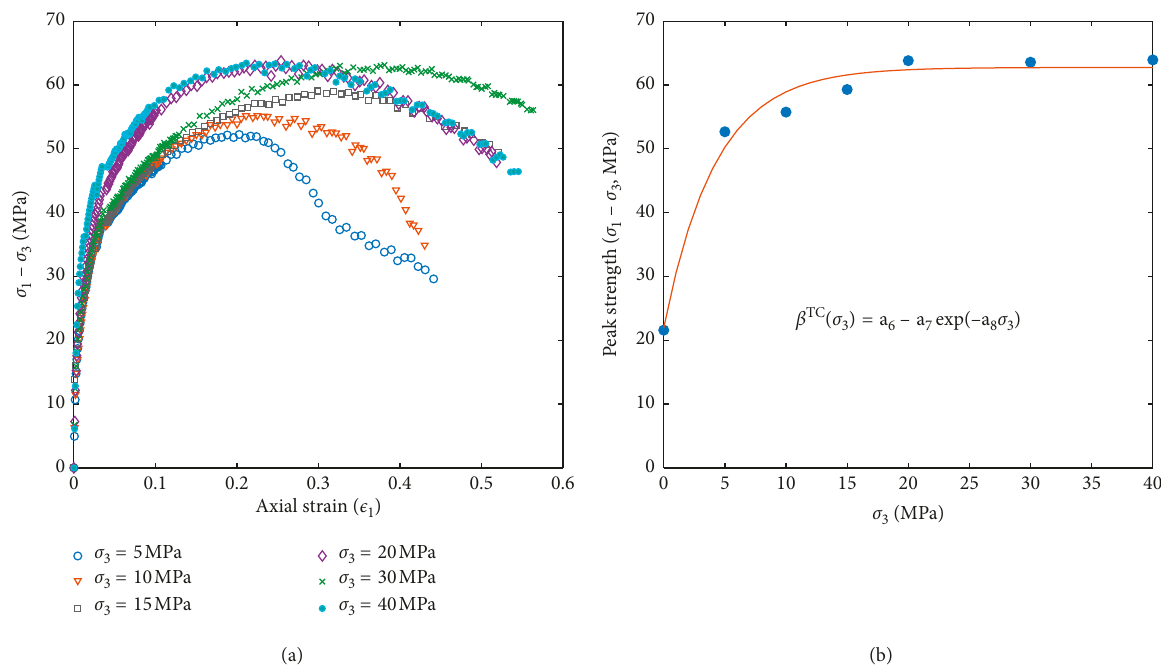
Figure 4: Stress-strain curves and peak strength of rock salt at different confining pressures. (a) Stress-strain curves. (b) Peak strength at different confinements.